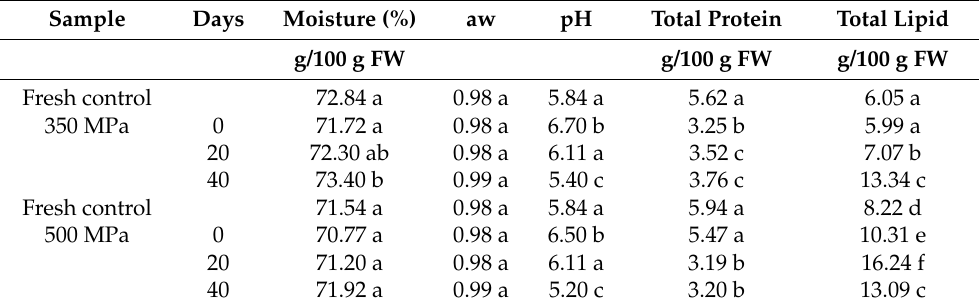
Table 4. Physicochemical analysis, aw, pH, total protein, and total lipid (g/100 g, FW) of fresh and HPP processed gonads of P. lividus .